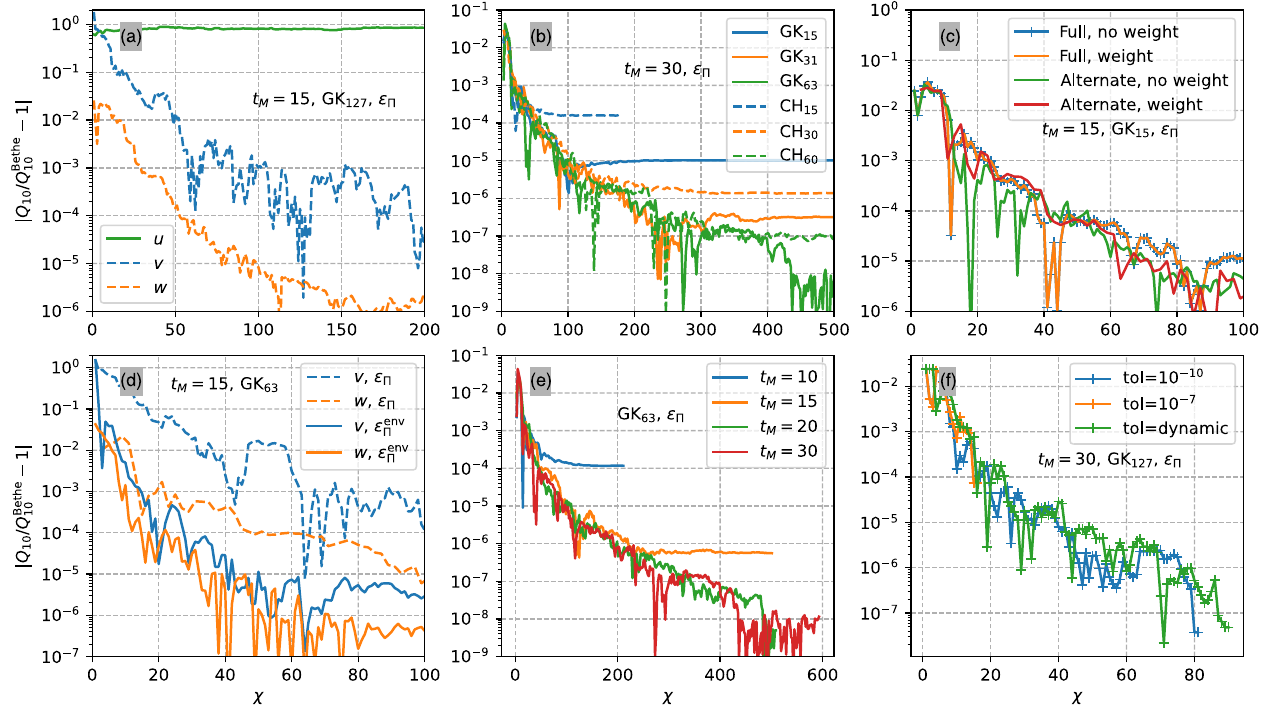
FIG. 15. Convergence with respect to the tensor rank χ of the ten-dimensional integral Q 10 , for the SIAM model. All panels show the relative error ϵ Q 10 ¼ j Q 10 ð χ Þ =Q Bethe 10 − 1 j measured against the Bethe ansatz solution versus the bond dimension χ . (a) Comparison of the choices of variables u , v , and w . (b) Comparison of different one-dimensional quadrature rules of d nodes: Gauss Kronrod (GK ) and d Chebyshev (CH ). (c) Comparison of different pivot selection algorithms, full search and alternate search , defined in Sec. III B 3, and d the weighted learning variant defined in Sec. III B 5. (d) Effect of using ϵ Π (23) or ϵ env Π (30) as the error function in the pivot selection. (e) Saturation of the error due to the maximum time cutoff t . (f) Absence of a dependence on the pivot acceptance condition; M see the